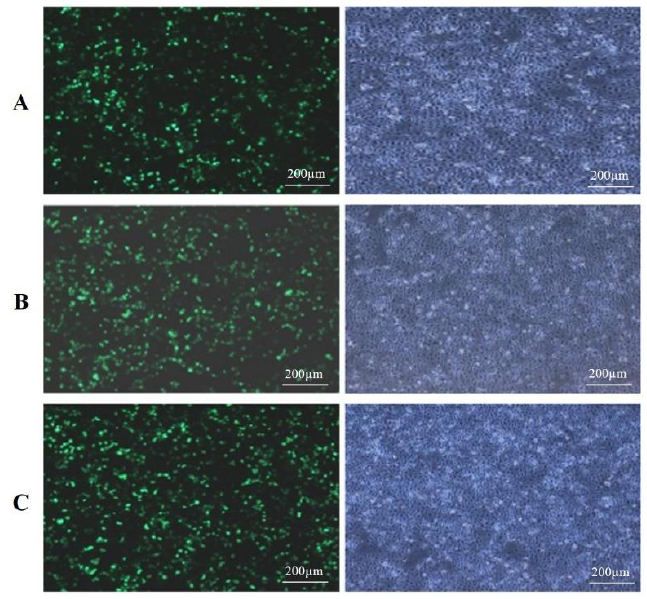
Figure 1. Cell morphology ( right side ) and GFP expression ( left side ) in BMECs under fluorescence microscope after 24 h of transfection with ( A ), bta-miR-148a-mimic; ( B ), bta-miR-148a-inhibitor; and Figure 2 ( C ), bta-miR-148a-shNC.